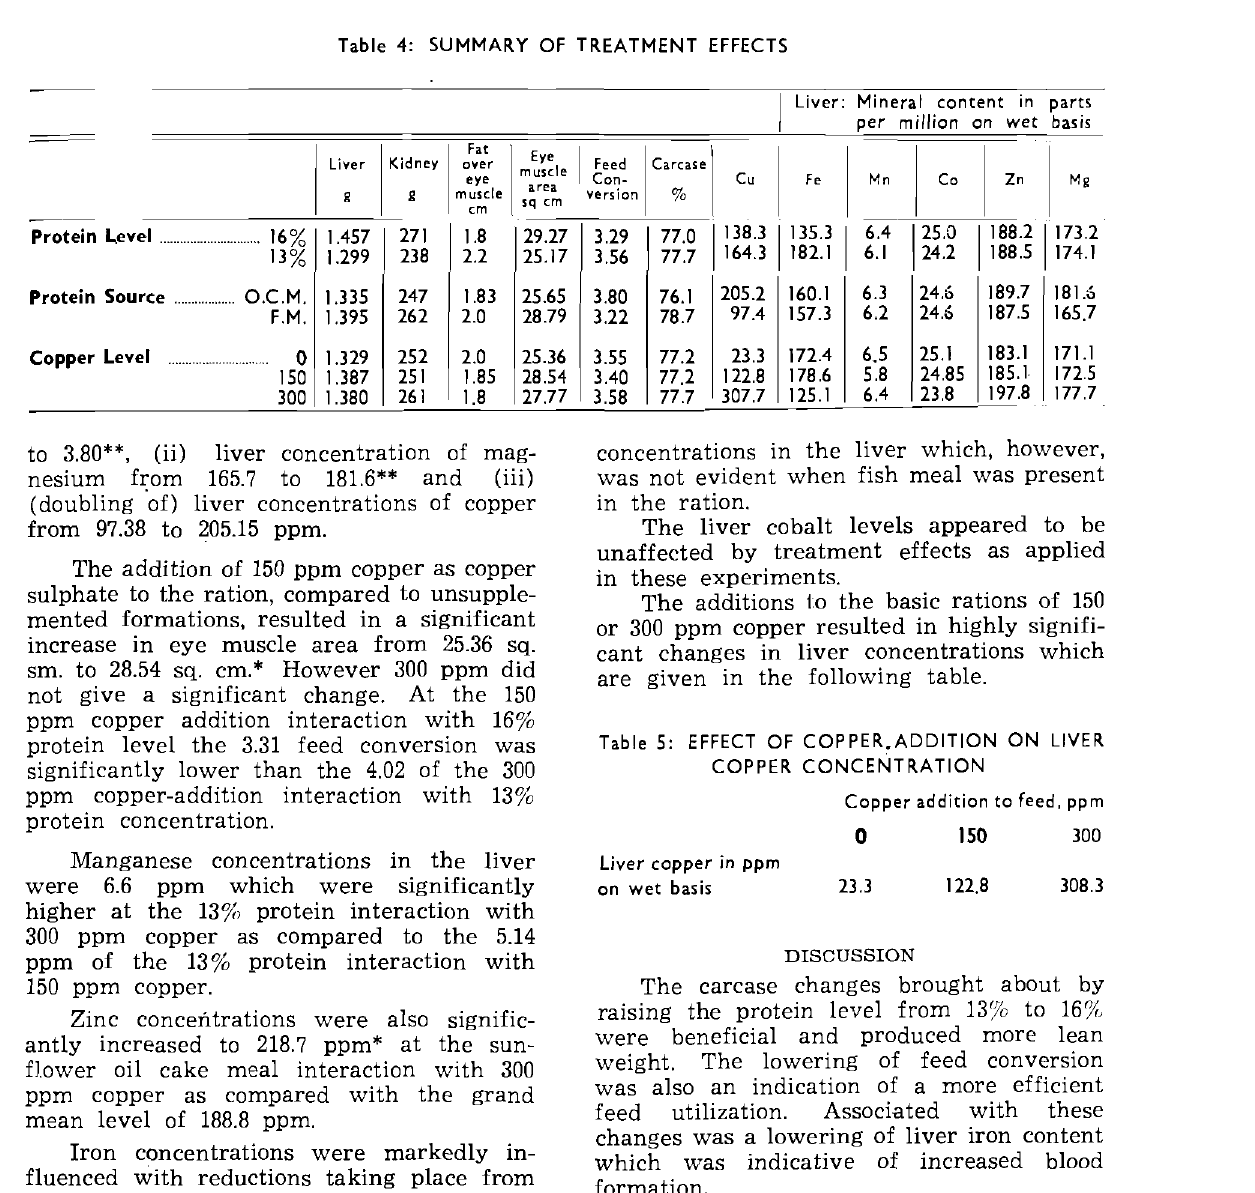
Table 4: SUMMARY OF TREATMENT EFFECTS